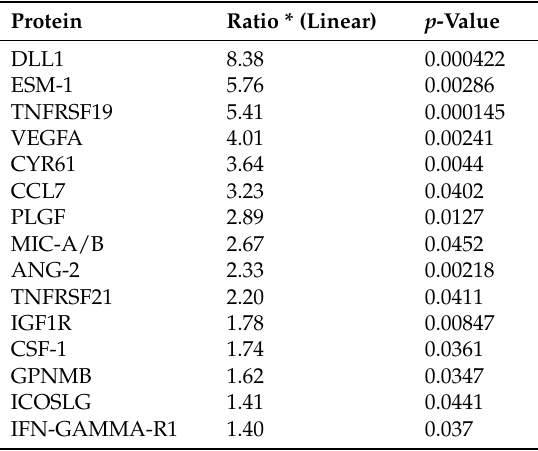
Table 4. Proteins related to recurrence in HPV positive TSCC and BOTSCC.